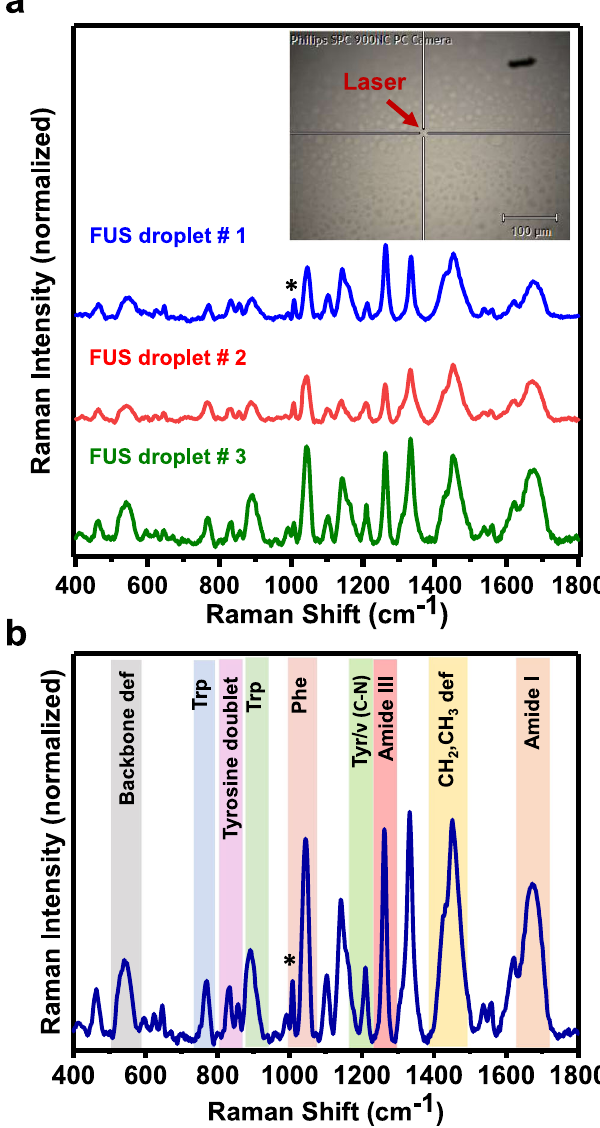
Fig. 3 | Single-droplet normal Raman spectroscopy. a Representative single- dropletnormalRamanspectraofafewindividualFUSdroplets(spectrarecordedat 500mWlaserpower,×100objective;numberofdroplets, n =3).Insetshowssingle droplets of FUS focussed through the Raman microscope. Arrowhead shows the focal point of the NIR laser within the droplet. b Average Raman spectrum of the FUScondensedphase.Allspectraarenormalizedwithrespecttothephenylalanine ringbreathingband at1007cm − 1 marked by anasterisk. See Methods for detailsof data acquisition, processing, and